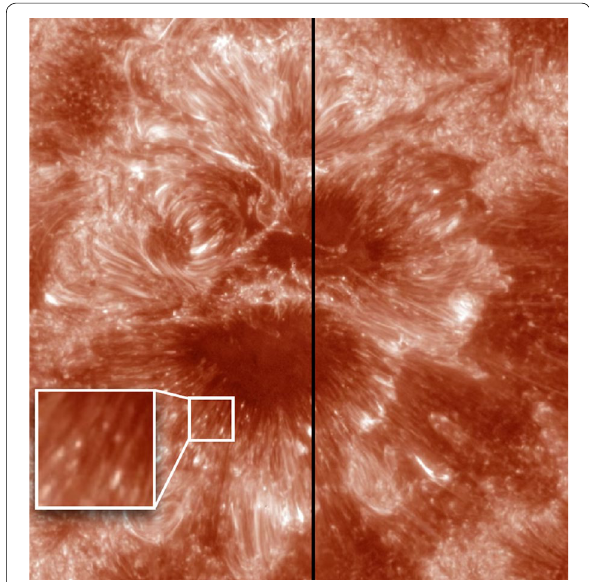
Fig. 4 A 1400 Å image of a sunspot taken by IRIS on Nov 19, 2014. The field of view of the image has a size of about 160 ″ small white box indicates a region where several penumbral bright dots (Tian et al. 2014b) are observed. The large white box shows a zoomed-in view of this